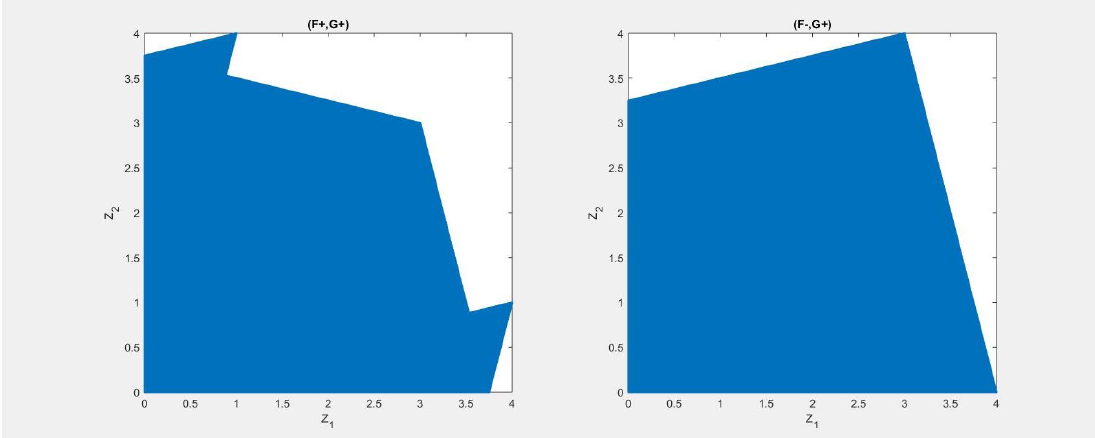
Figure 1: Support of ( Z 1 , Z 2 ) . Left panel: F = F + , G = G + . Right panel: F = F − , G = G +